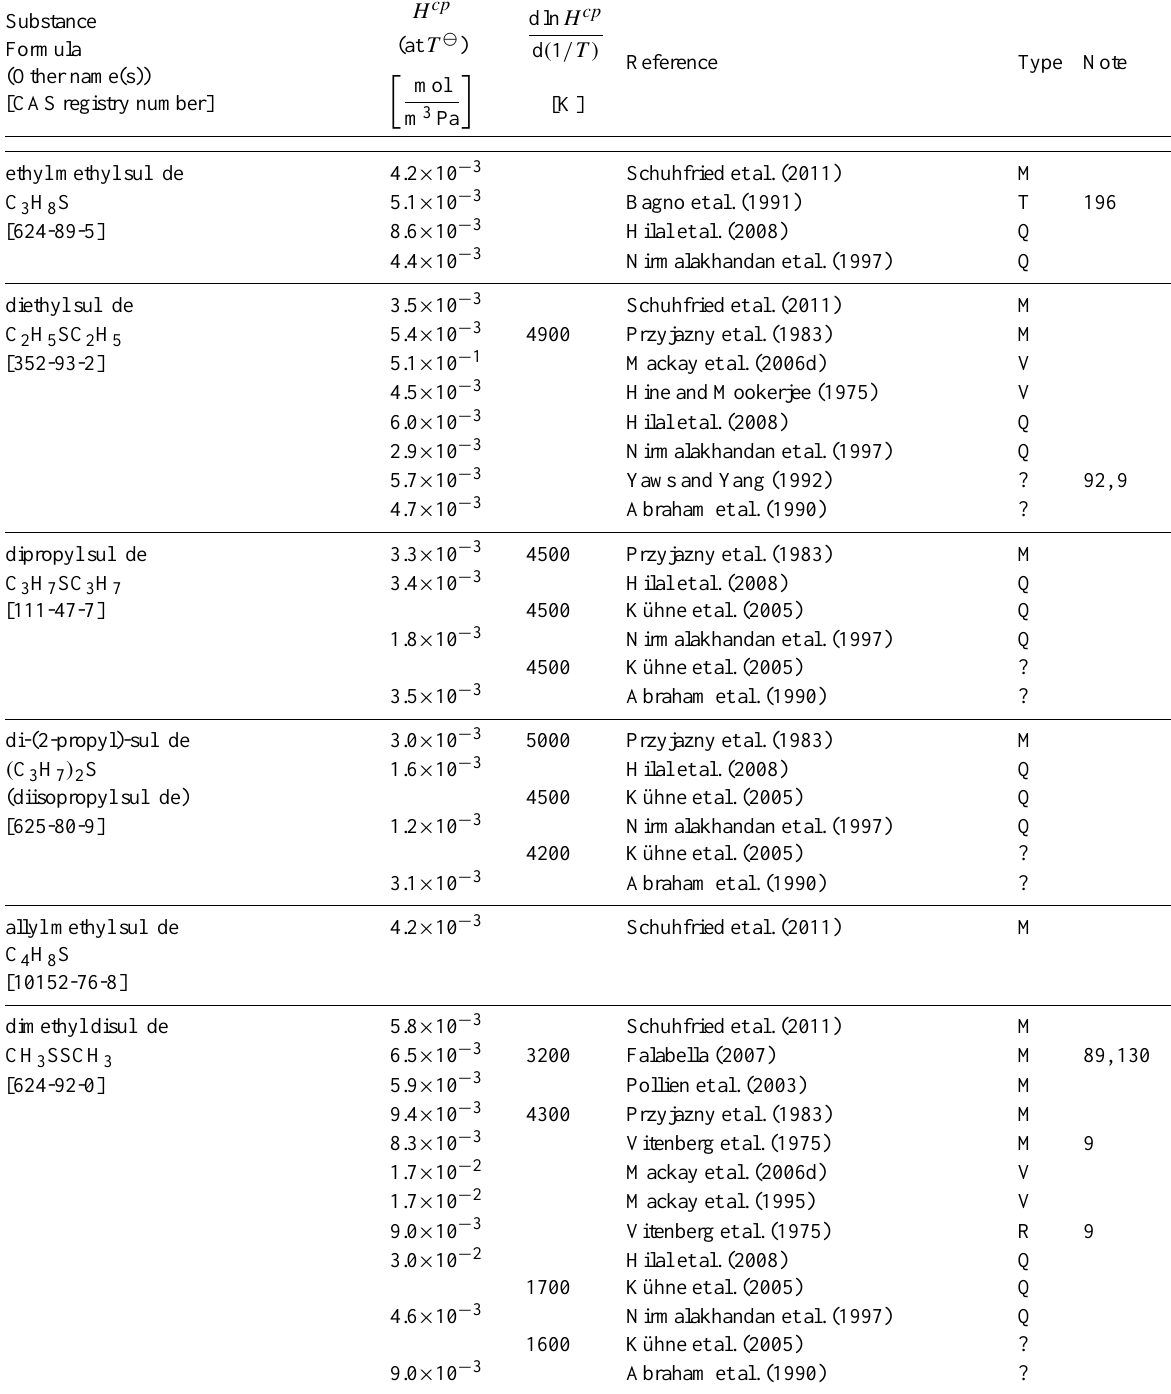
Table 6: Henry’s law constants for water as solvent